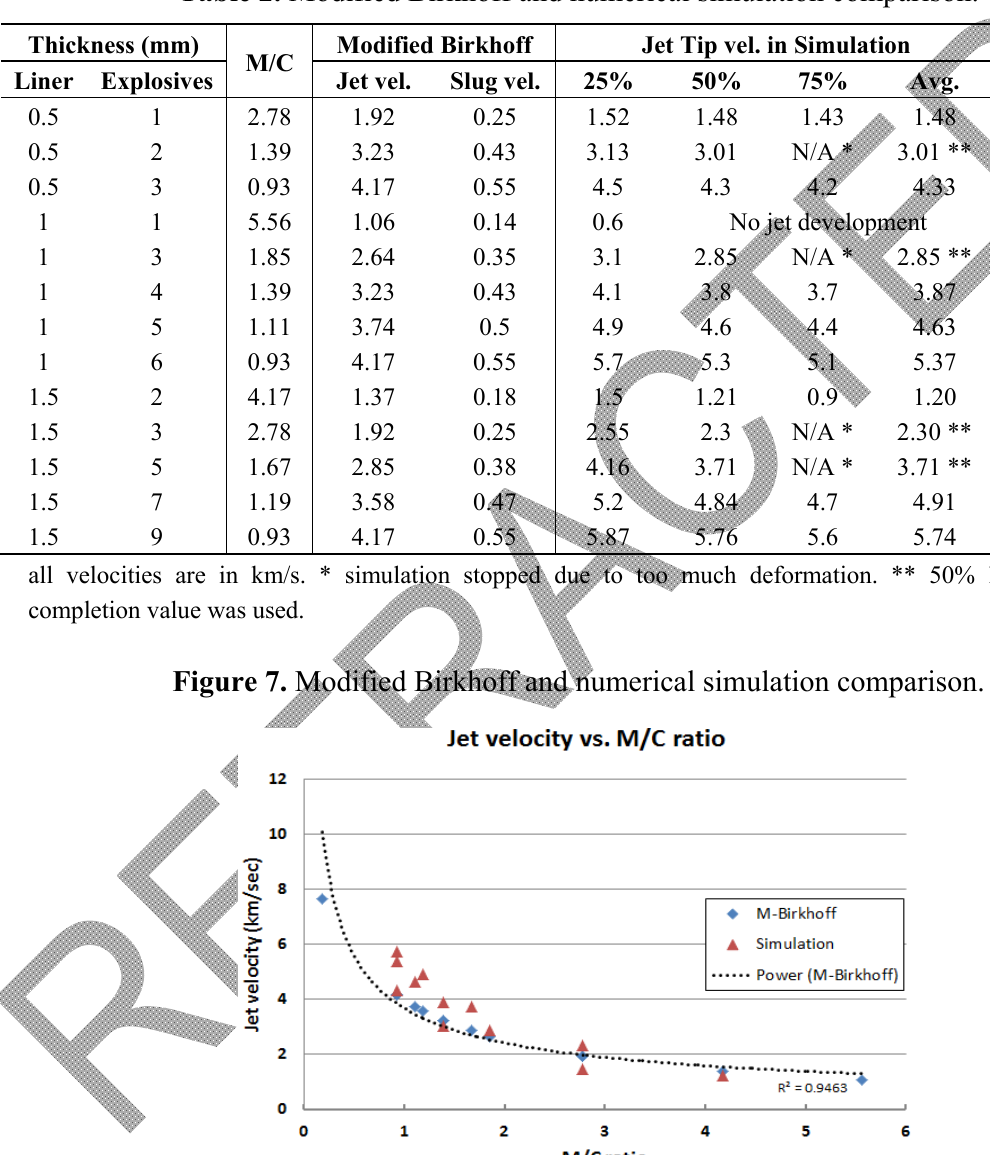
Table 2. Modified Birkhoff and numerical simulation comparison.